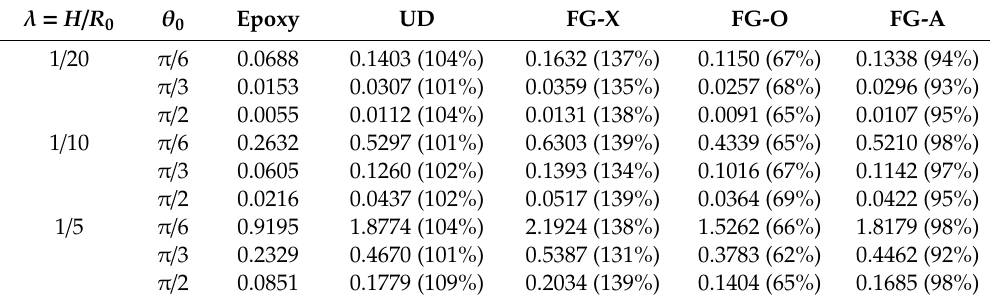
Table 7. The fundamental frequency Ω of C-C FG-GPLRC circular arch.